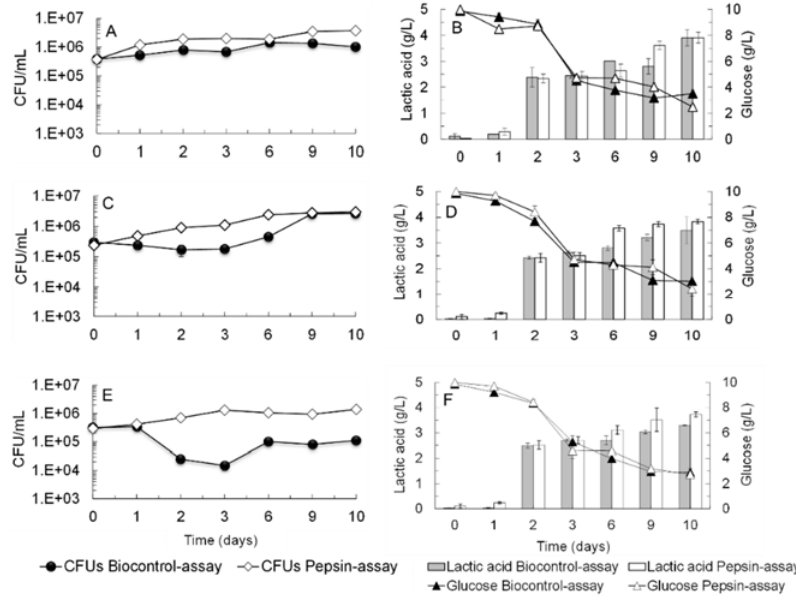
Figure 4. Culturability ( A , C , E ), glucose consumption and lactic acid production ( B , D , F ) during growth assays performed with L. brevis ( A , B ), L. hilgardii ( C , D ) and L. plantarum ( E , F ), inoculated in a cell ‐ free supernatant pre ‐ fermented by S. cerevisiae ER without any treatment (biocontrol assay) and after a pepsin treatment (pepsin assay). Data represented correspond to means ± SD (error bars) of two independent biological assays.